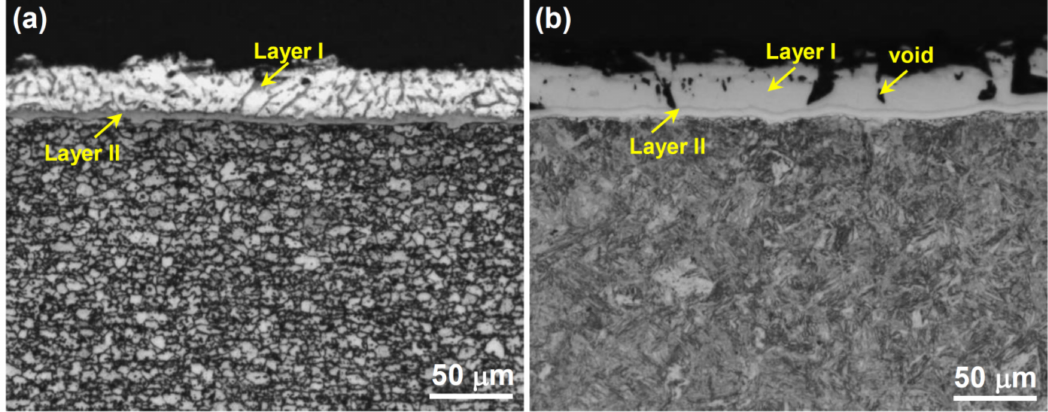
Figure 2. Cross-sectional optical microstructures of Al-Si coated specimens, as-received state ( a ) and after hot-stamped at 1193 K ( b